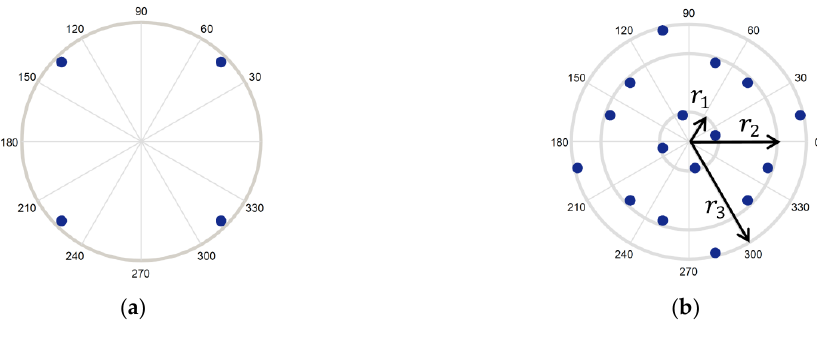
Figure 5. Constellation diagrams: ( a ) QPSK signal; ( b ) golden-coded QPSK signal.